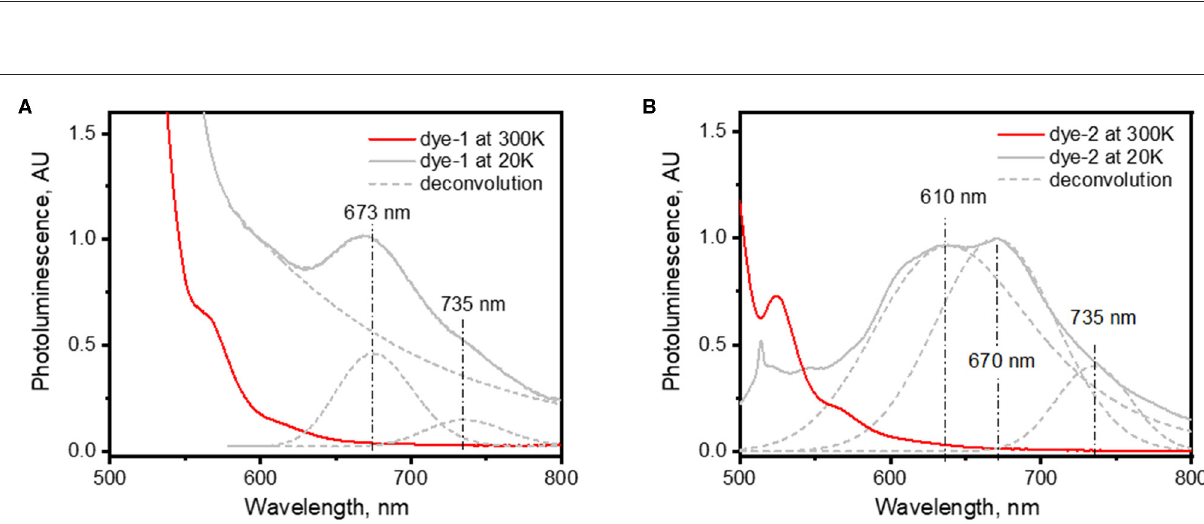
Frontiers in Chemistry | www.frontiersin.org